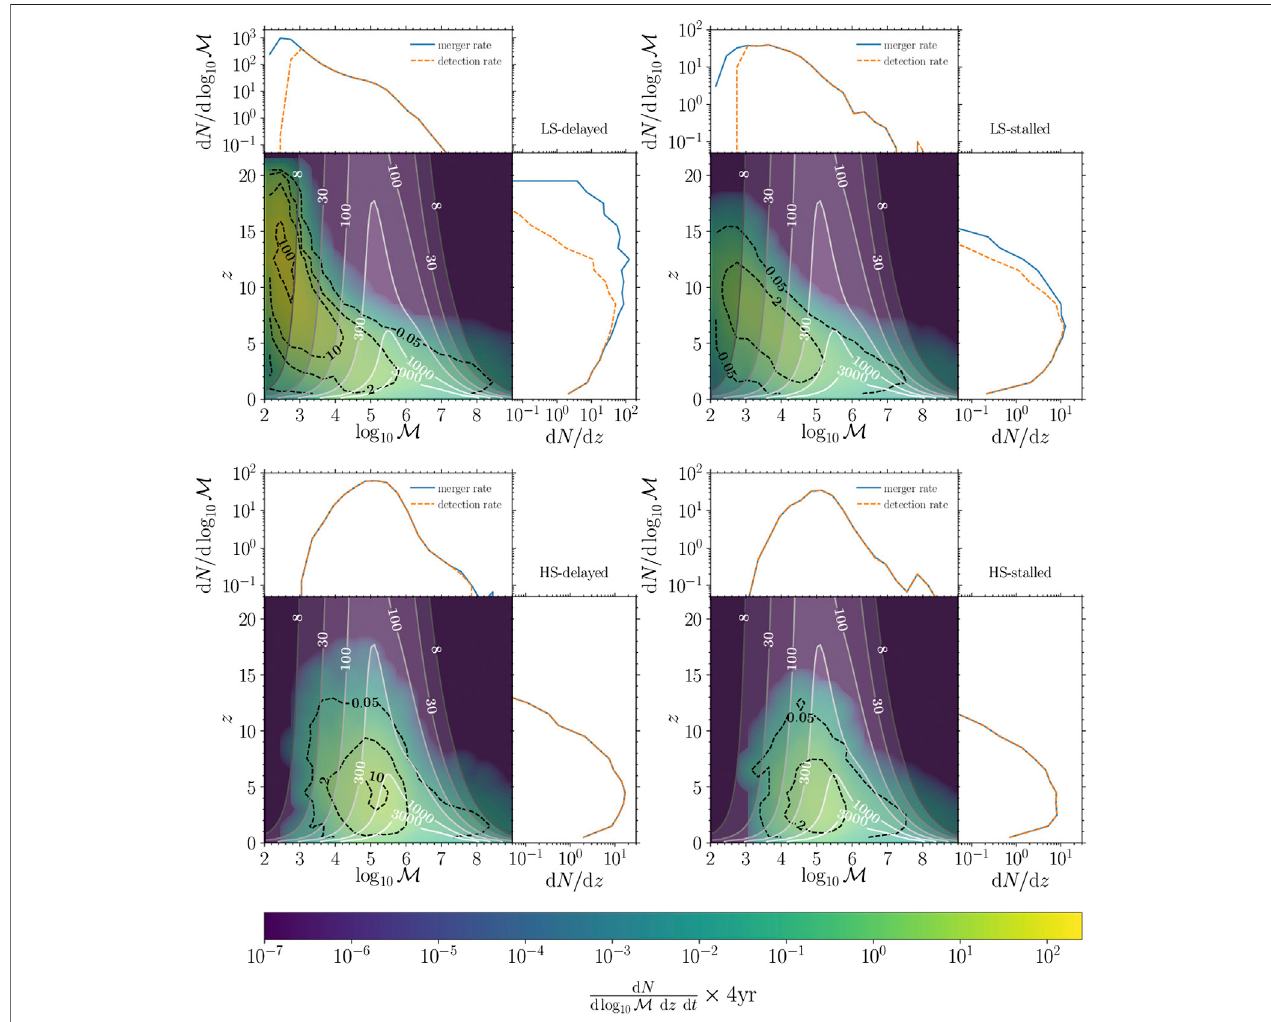
FIGURE2| LISAobservationalcapabilitiesvs.predictedMBHBmergerratesinthechirpmass-redshiftplane.Ineachpanel,grayshadedcontoursshowtheS/Nof LISA observations for equal-mass, nonspinning binaries. The superimposed yellow-green color gradient with black dashed contours represents the differential number of mergers during the planned 4-year mission lifetime. From the upper-left panel, clockwise, we show four different astrophysical models: LS-delayed, LS-stalled, HS- stalled,andHS-delayed(Bonettietal.,2019,fordetails).Foreachmodel,theupperandright-sidepanelsshowthemergerrate(blueline)anddetectionrate(orange line) distributions marginalized over redshift and chirp mass, respectively (Bonetti et al., 2019).